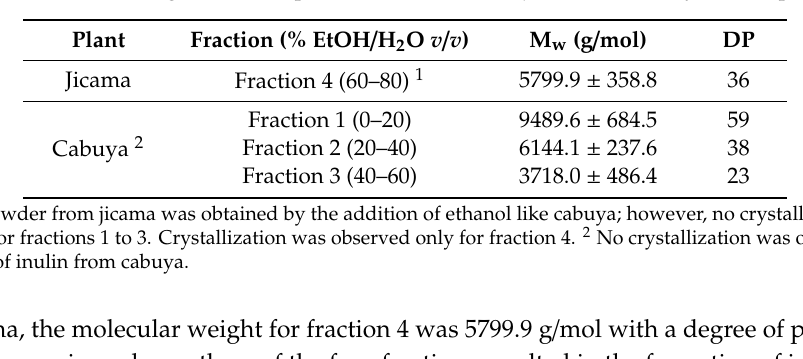
Table 1. Molecular weight of inulin powder obtained from jicama and cabuya inulin